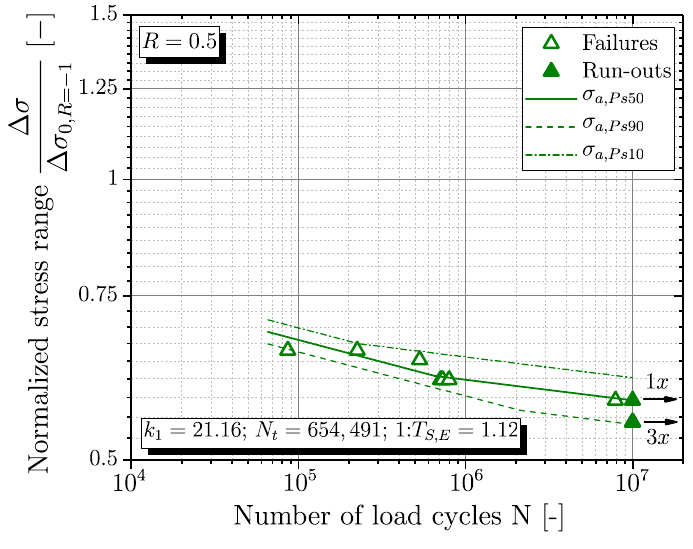
Figure 8. Evaluated S-N curve at R = 0.5.